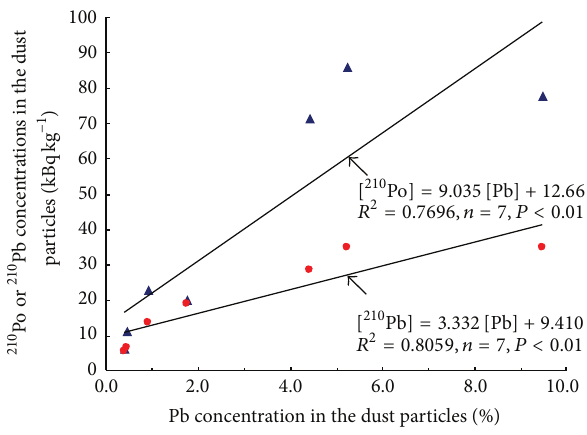
Figure 1: The activity concentrations of 210 Po or 210 Pb as a function of the Pb contents in the dust particle samples collected in the filter and chimney of the ILVA